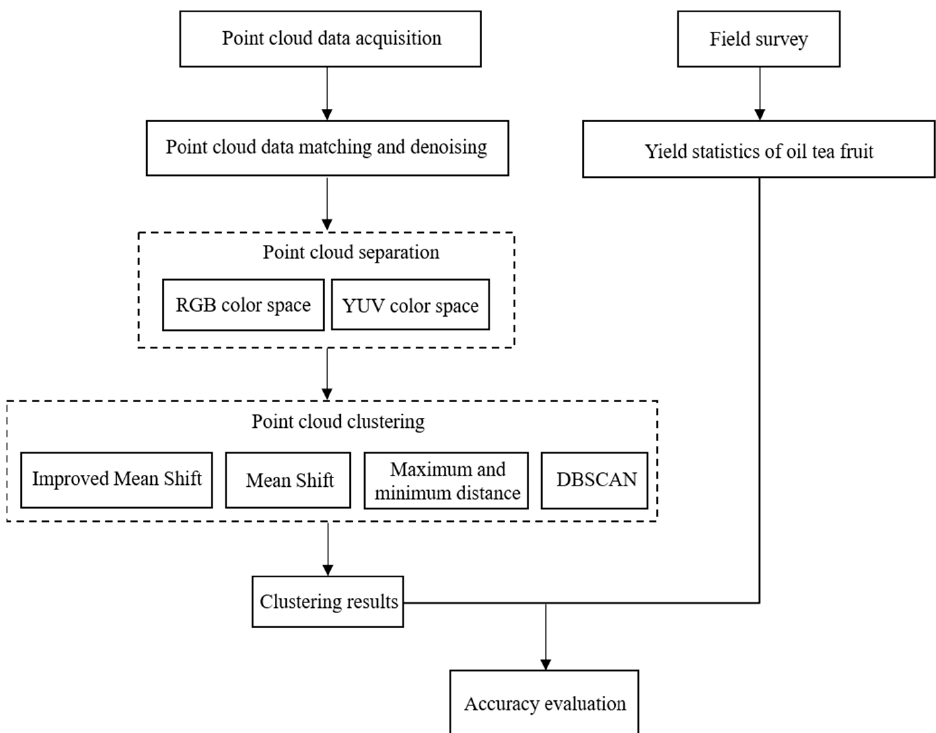
Figure 2. Methodological framework of yield identification of the oil tea fruit in this study.